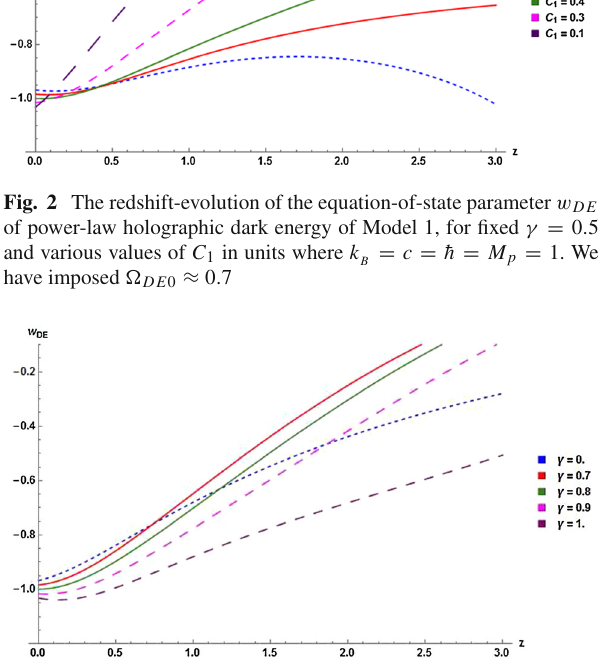
Fig. 3 The redshift-evolution of the equation-of-state parameter w DE of power-law holographic dark energy of Model 1, for fixed C 1 = 0 . 35 and various values of γ in units where k have imposed (cid:7) DE 0 ≈ 0 .